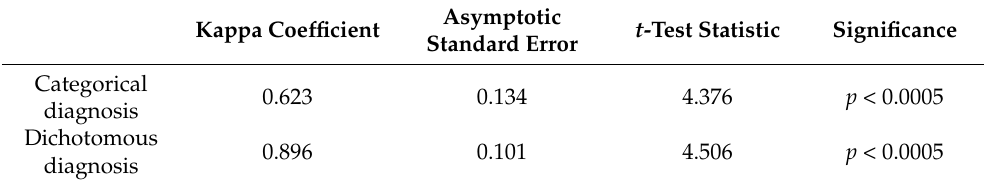
Table 2. Kappa coefficients for categorical diagnosis and dichotomous